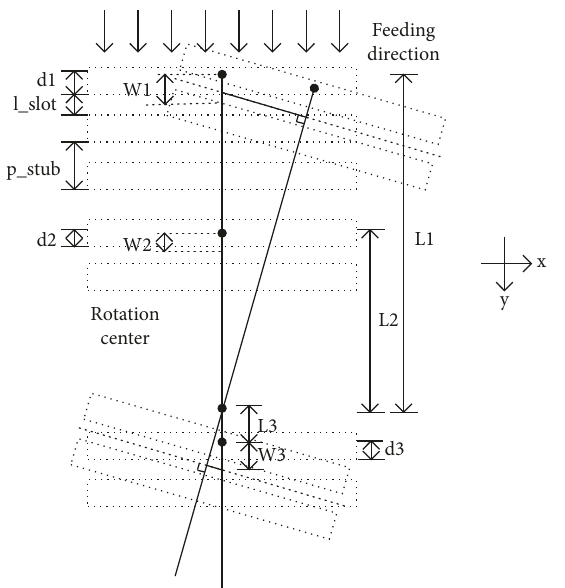
Figure 4: Waveguide path length difference of two VICTS sub- arrays in the y -direction.